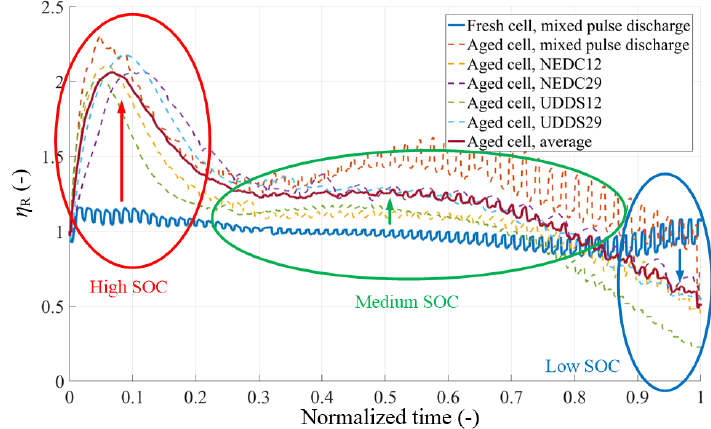
Figure 7. The estimated η R at the aged cell compared to the fresh cell. The changes in the η R due to aging are very similar at any mission profile. In the high SOC region, the η R is rapidly growing. Over the middle SOC region, the η R slightly grows. Finally, in the low SOC region, the η R